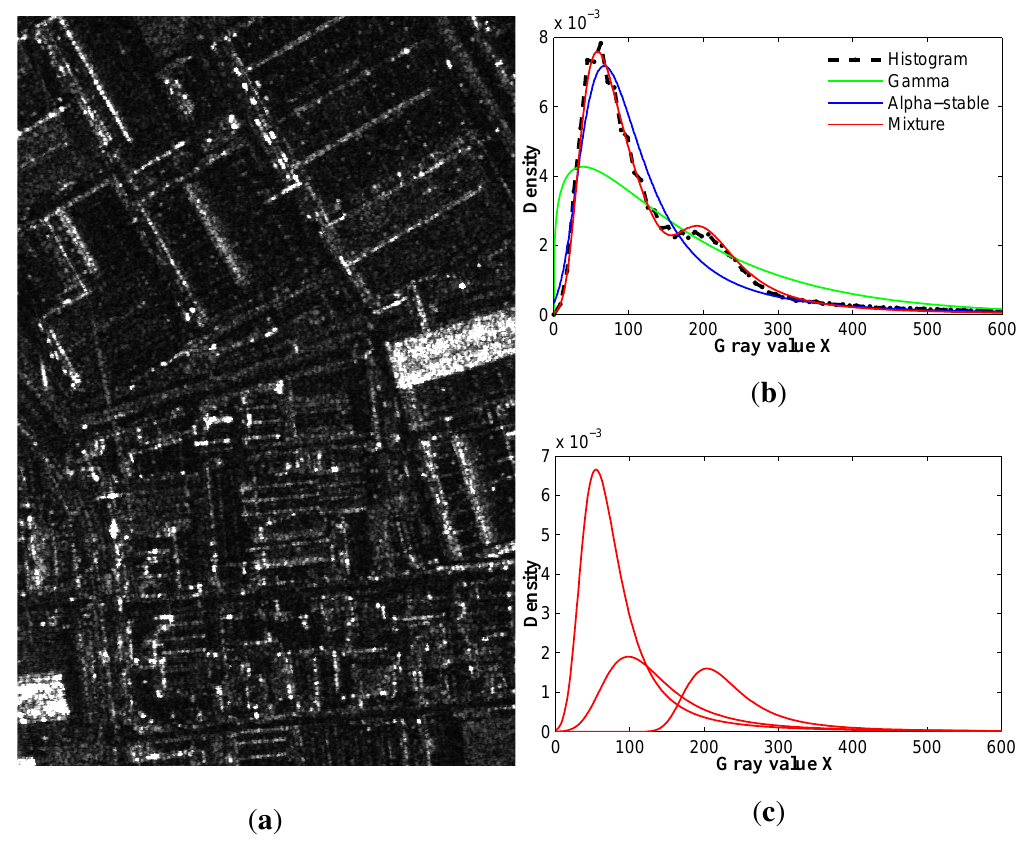
Figure 4. Selected building area and fitting results. ( a ) Building area in SAR image; ( b ) Fitting results by different models; ( c ) Three components of the estimated MAS distributions.